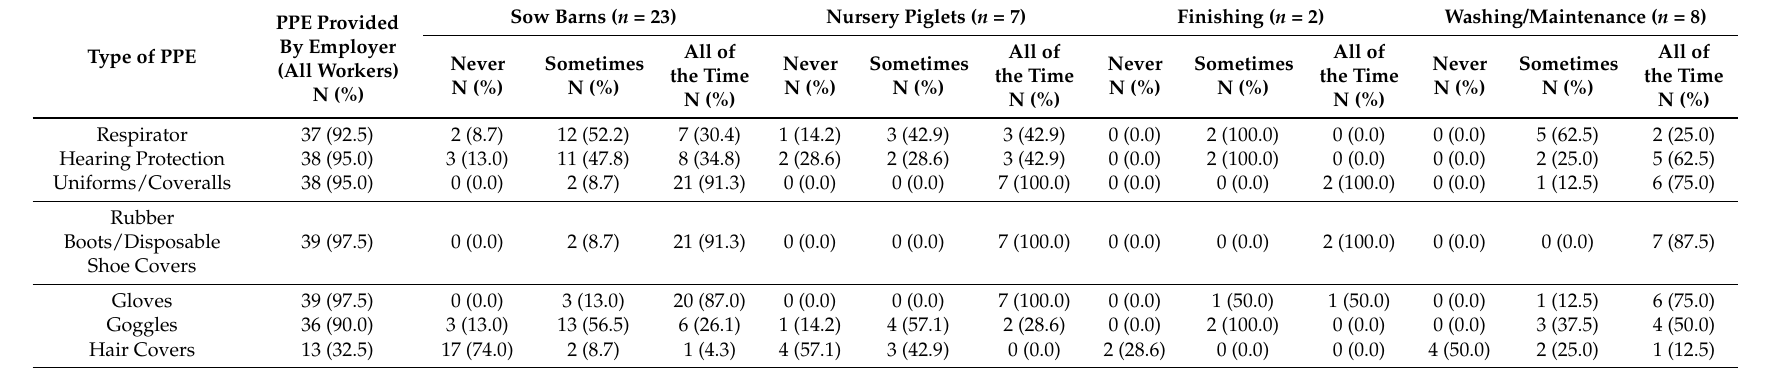
Table 3. Provision and frequency of use of personal protective equipment